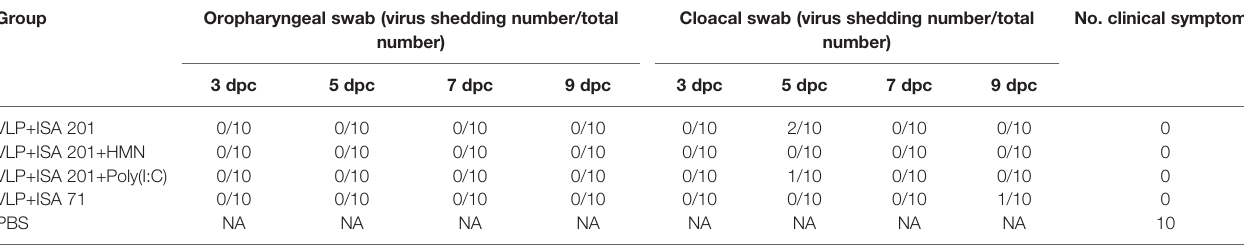
TABLE 4 | Virus shedding after a lethal-dose E157 AIV challenge of chickens.